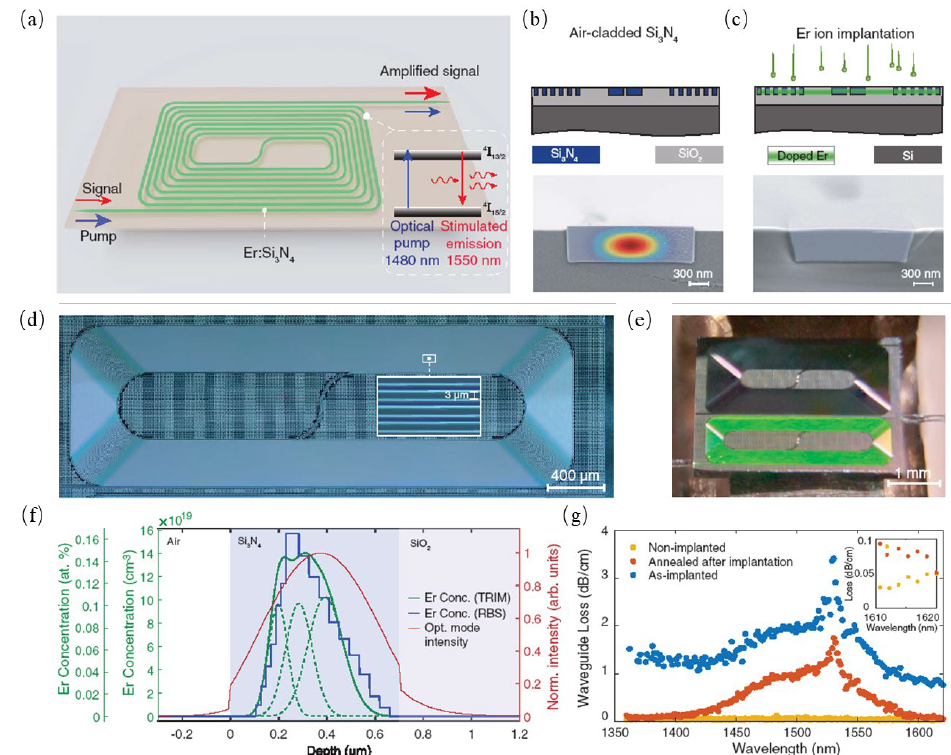
Figure 7. ( a ) The structure of the Si 3 N 4 :Er waveguide amplifier. ( b ) The damascene process and the optical mode in the waveguide. ( c ) The ion implantation process. ( d ) The optical image of the 0.5 m long waveguide. ( e ) The waveguide amplifier butt-end coupled with fibers ( f ) The calculated Er concentration (green), simulated optical mode (red) and measured concentration (blue) by RBS. ( g ) Measured propagation losses before ion implantation, as-implanted, and after annealing [41]. Reprinted/adapted with permission from Ref. [41]. 2022, The American Association for the Advancement of Science.